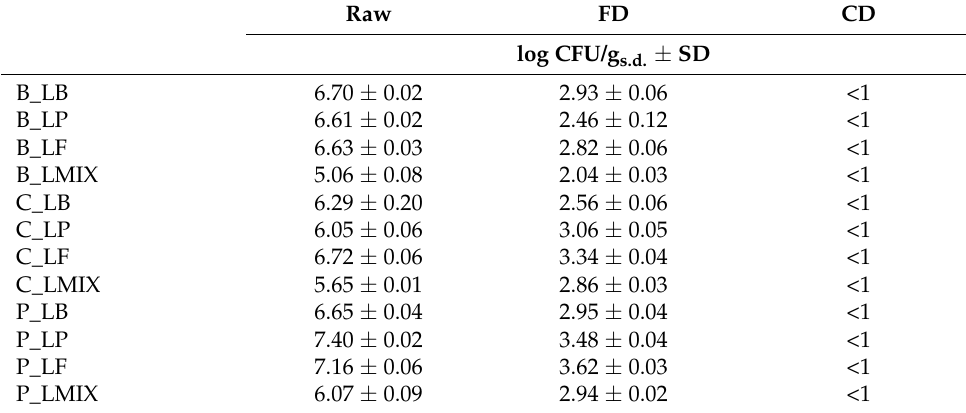
Table 2. Concentration of LAB in raw or fermented